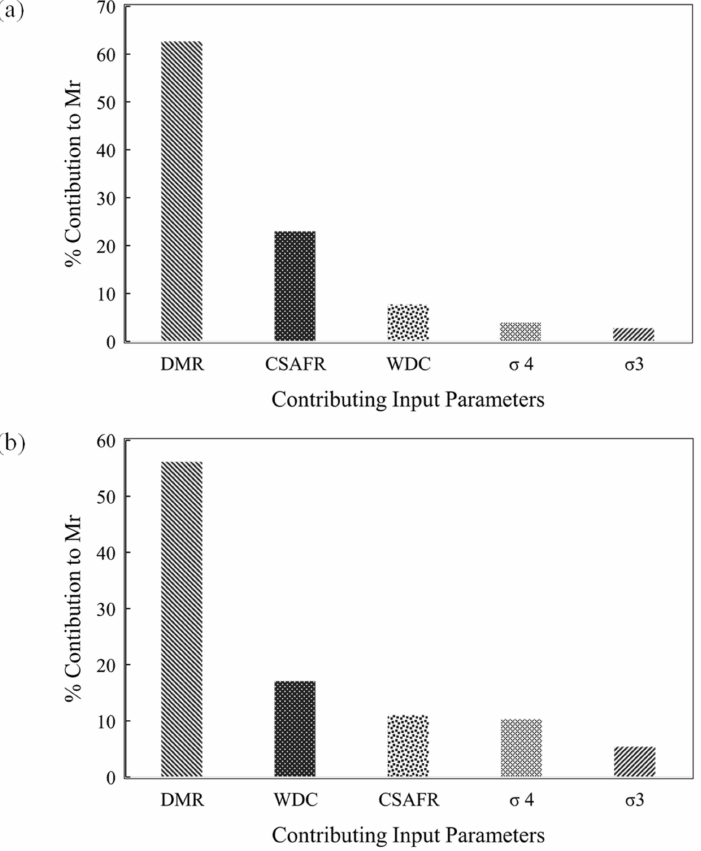
Figure 5. Importance of the variables reflected from ( a ) the ANN model and ( b ) the GEP